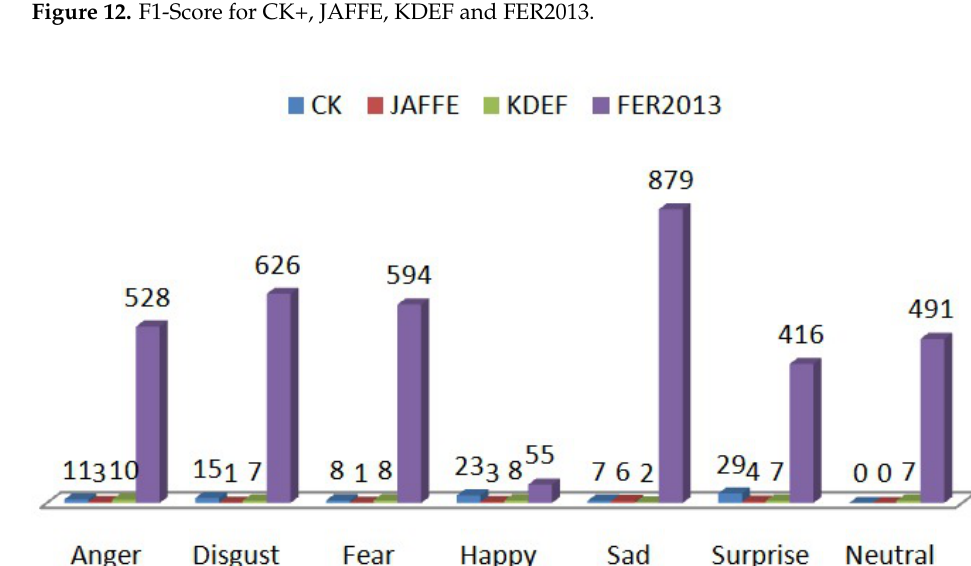
Figure 13. Support for CK+, JAFFE, KDEF and